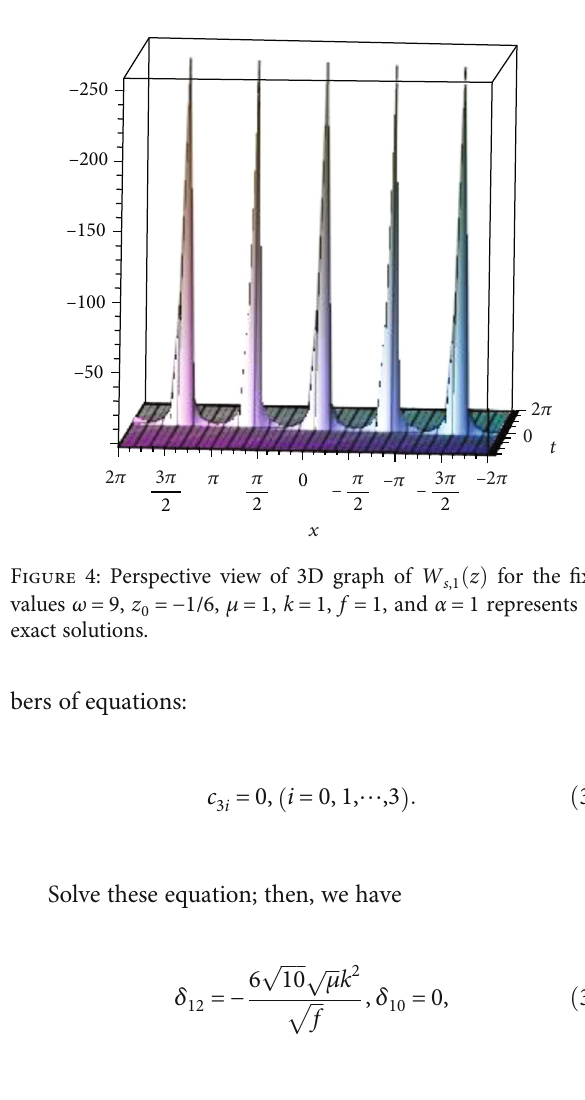
ð z Þ for the fi xed r ,1 Figure 3: Perspective view of 3D graph of W values ω = 9 , z 0 = 1/6 , μ = 1 , k = 1 , f = 1 , and α = 1 represents the exact solutions.